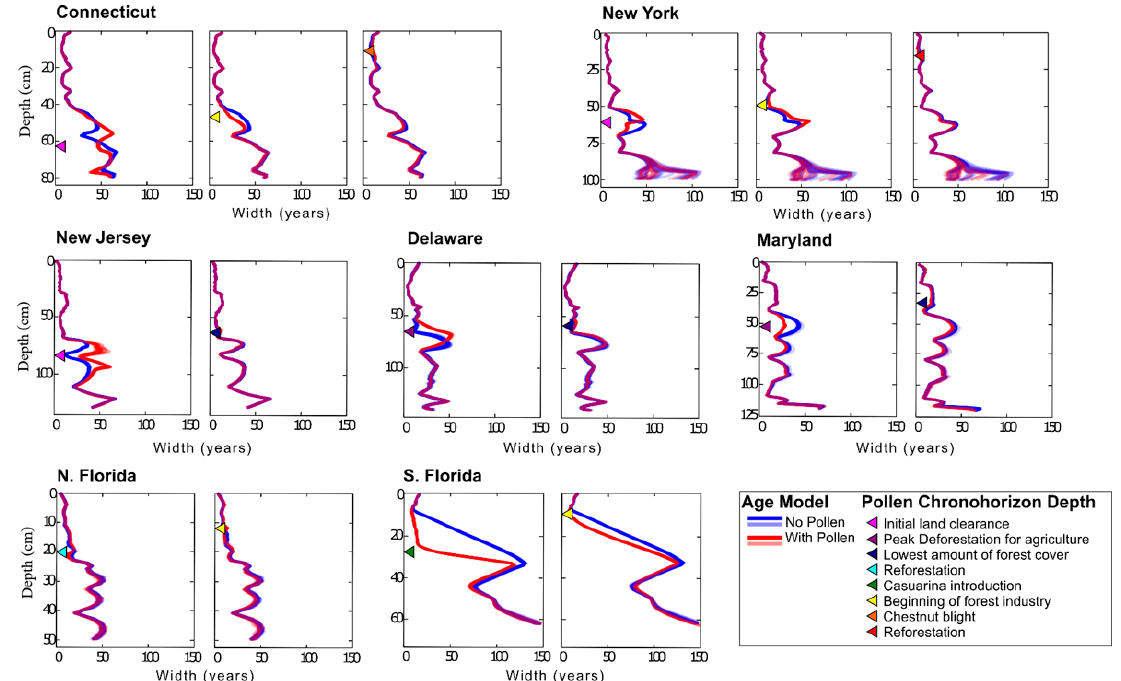
Figure A2. Comparison of the difference in width of the 50% UI between the WP (red) and the NP (blue) models for each of the individual chronohorizon models over the interval from 1500 CE through the present. The red and blue lines are plotted transparently so that lighter areas represent widths that are predicted less frequently by Bchron, while darker areas represent widths that are predicted more frequently.